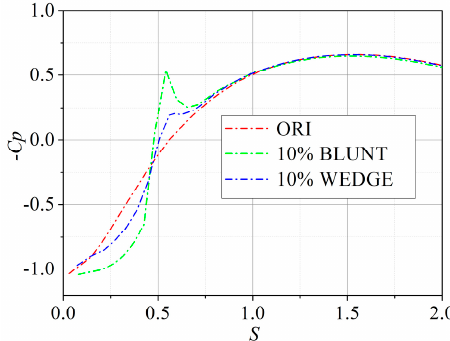
Figure 4. The Cp of the elliptical leading edge and deformations.